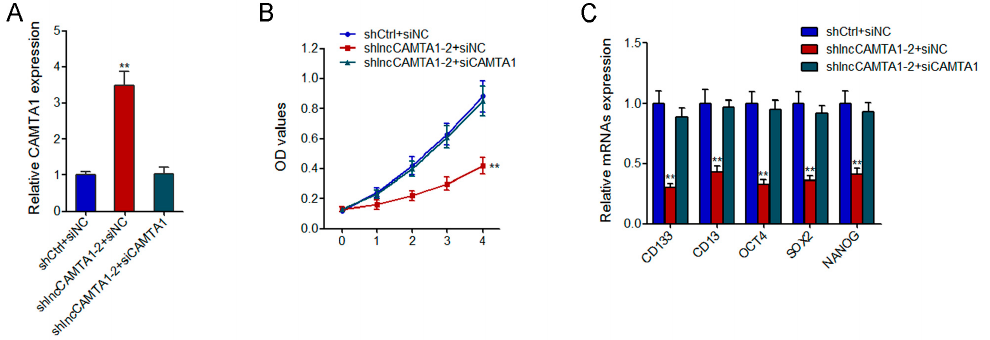
Figure 8. CAMTA1 is required for the effects of lncCAMTA1 on HCC cell proliferation and stemness properties. ( A ) CAMTA1 expression in lncCAMTA1 stably depleted and control HepG2 cells;